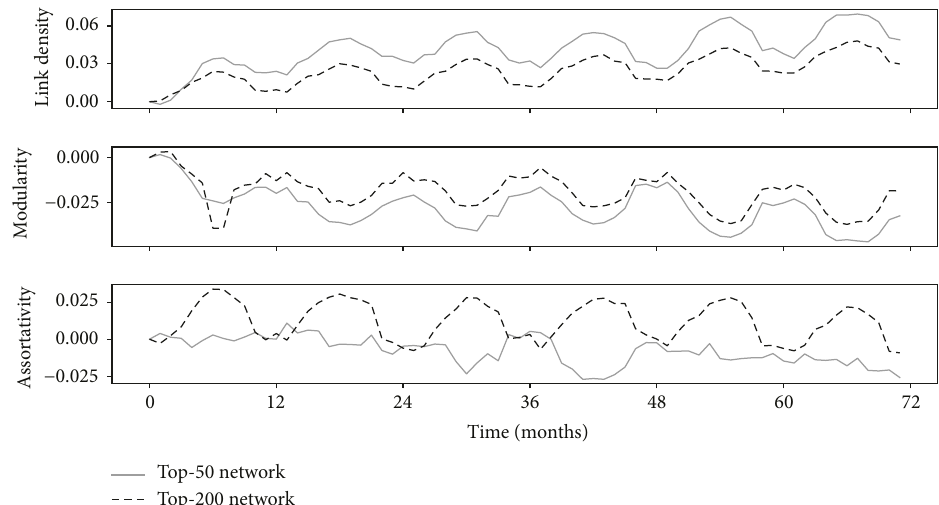
Figure 3: Evolution of the link density, modularity (as calculated through the Louvain’s algorithm [19]), and assortativity of the world air transport network through time. Solid and dashed lines, respectively, represent the networks for the top-50 and top-200 world airports. All series are normalised by subtracting the value at 𝑡 = 0 , in order to make them start from 0.0 .